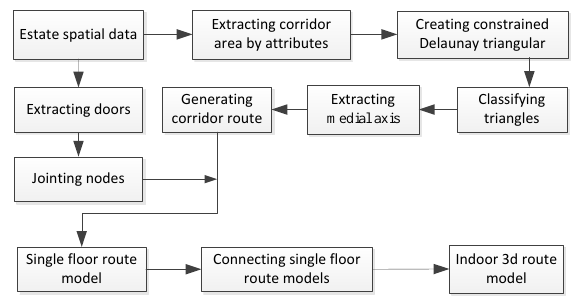
Figure 4 The process of building space modelling